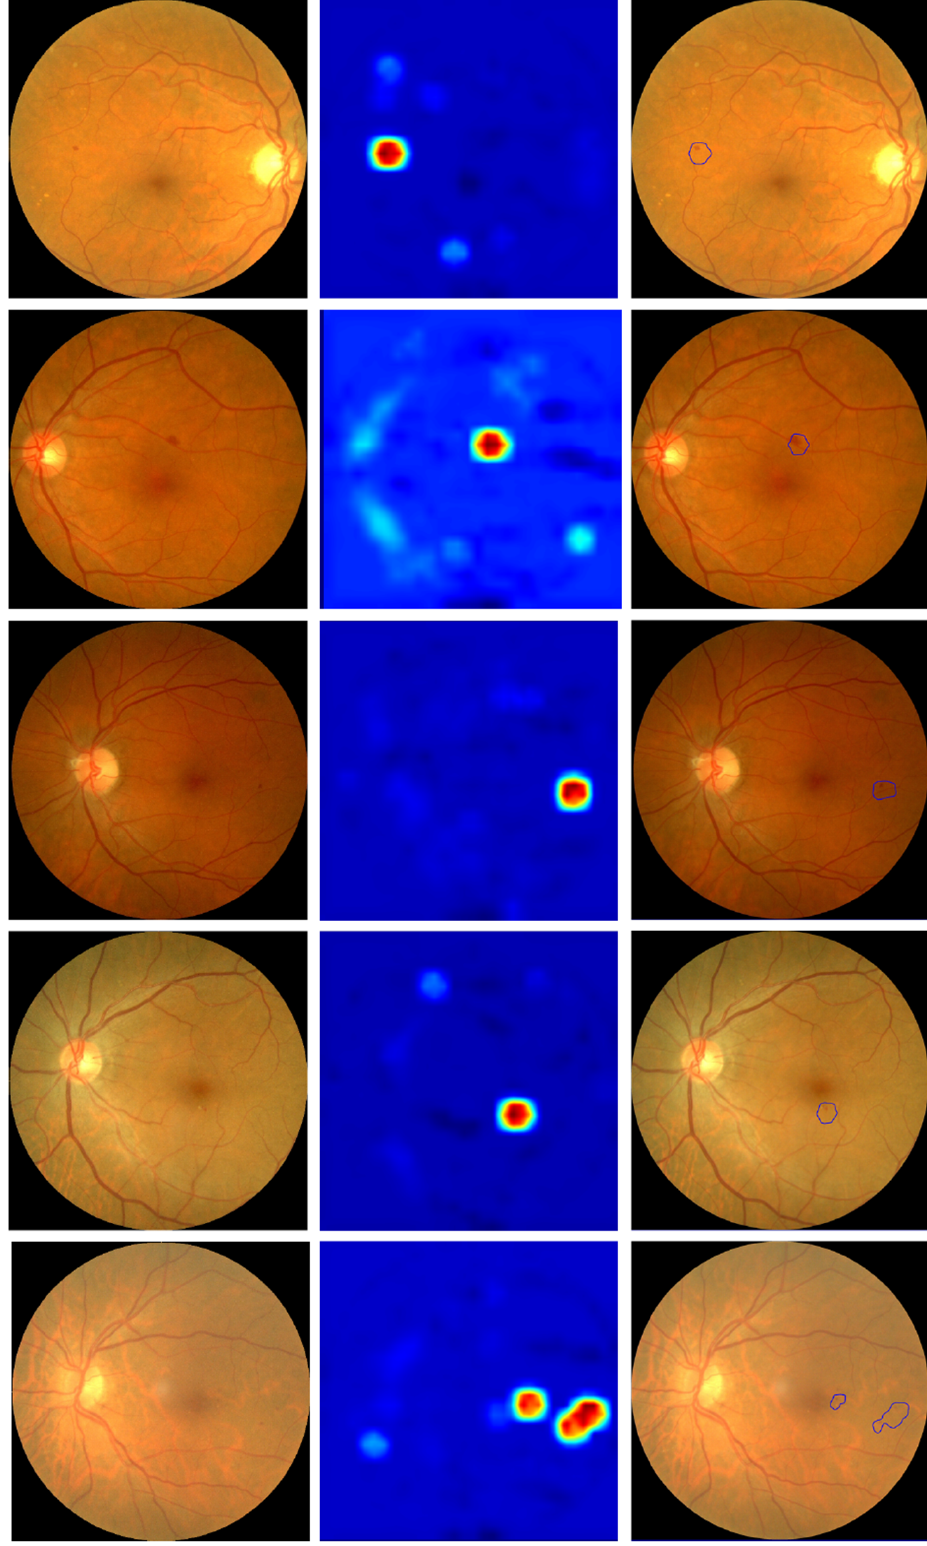
Figure 5. First column: input retinography. Second column: multiscale activation maps. Third column: automatic selection of areas of interest based on activation maps.